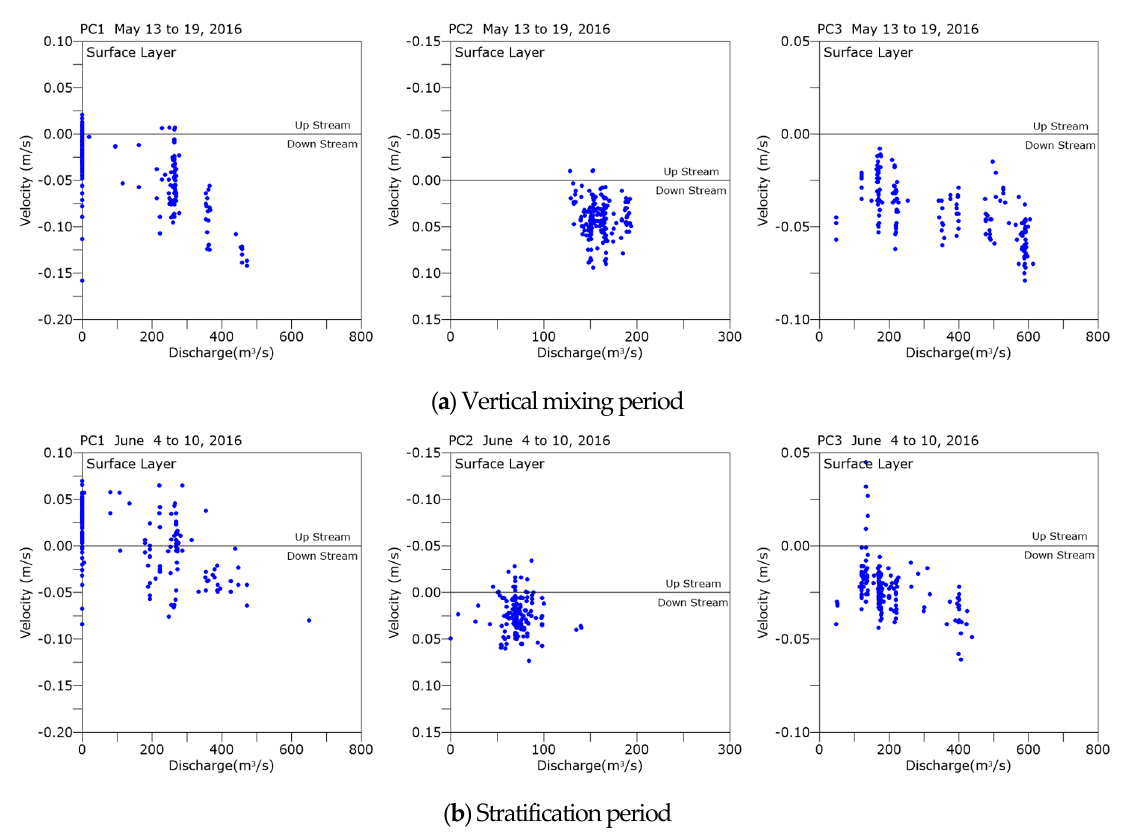
Figure 10. Relationships between velocity and discharge.